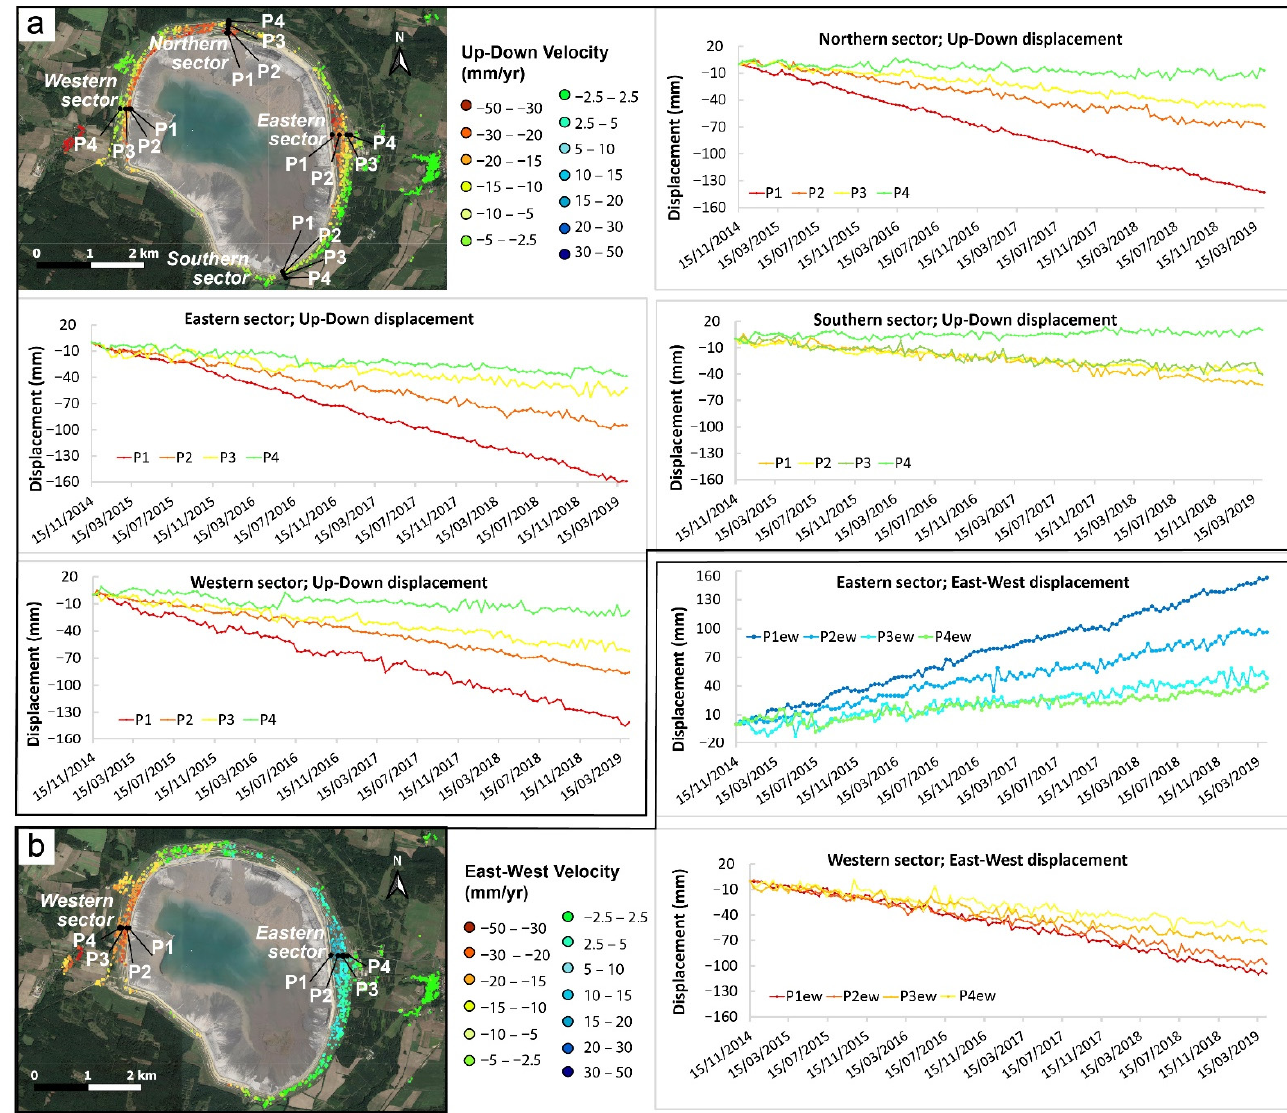
Figure 5. Time series of displacement for the Ż elazny Most TSF; ( a ) time series of up-down displacements for the northern, southern, eastern and western sectors of the dam; downward displacements are in red; ( b ) time series of east-west displacements for the eastern and western sectors of the dam; eastward displacements are in blue, westward displacement are in red. The location of the PSs selected for processing the time series is also shown in the map panels.